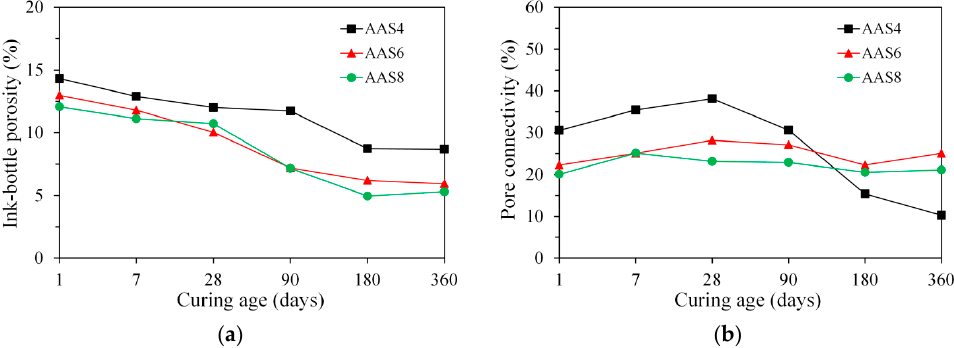
Figure 9. The ink-bottle porosity ( a ) and pore connectivity ( b ) as a function of time up to 360 days, derived from MIP. In the graphs, AAS indicates alkali-activated slag, and the number following AAS refers to the weight percentage of Na 2 O with respect to slag. For all samples, the water to slag ratio was 0.4 and the curing temperature was 20 °C.